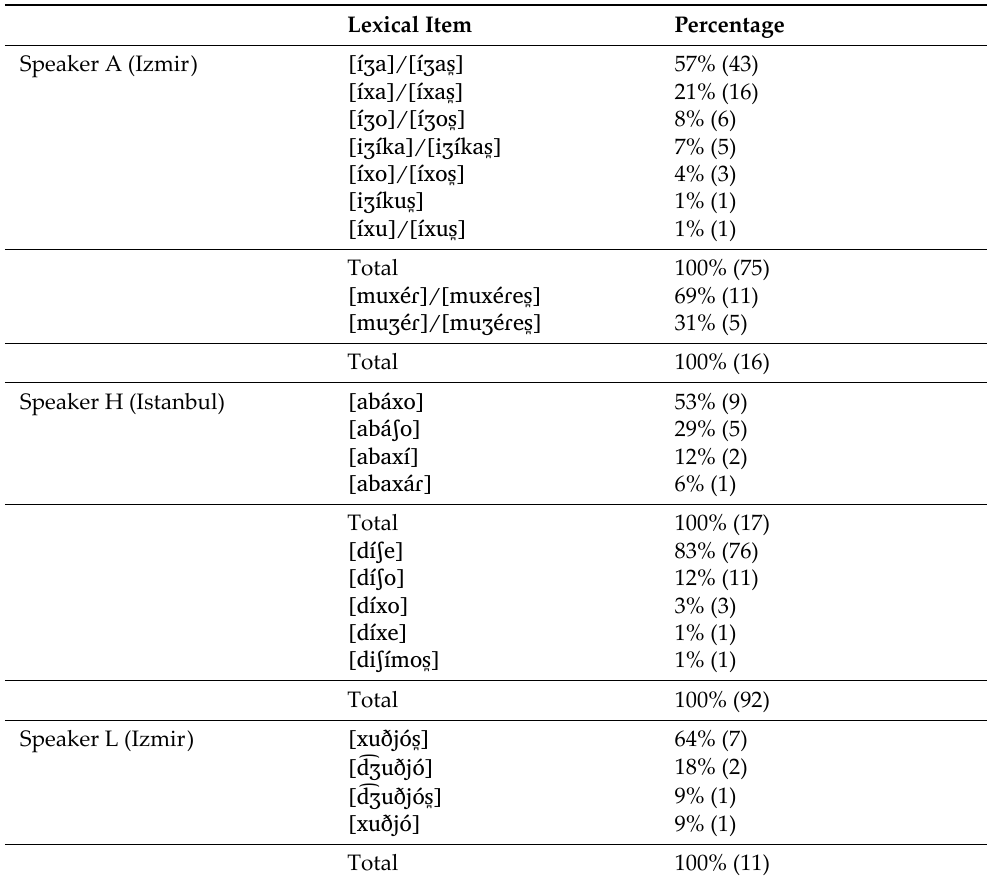
Table 2. Token frequency counts from the COJUT XXI showing intra‑ and inter‑speaker variation in accommodation to MS / x /, based on the lexemes for ‘son/daughter’, ‘wife’, ‘down/to descend’, ‘to say’, and ‘Jewish’, as pronounced by three Turkish JS speakers whose linguistic repertoire also includes MS (adapted from Spiegel 2020, pp. 271, 277–78,